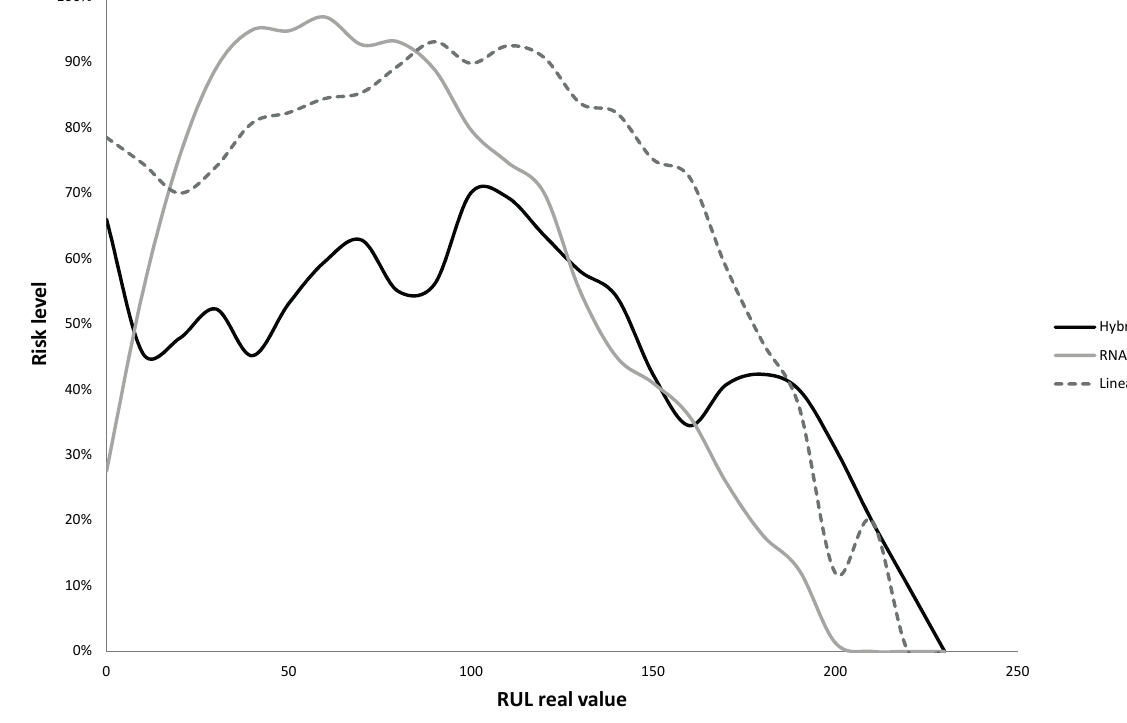
Figure 6. Risk level of the hybrid model compared with the two benchmark